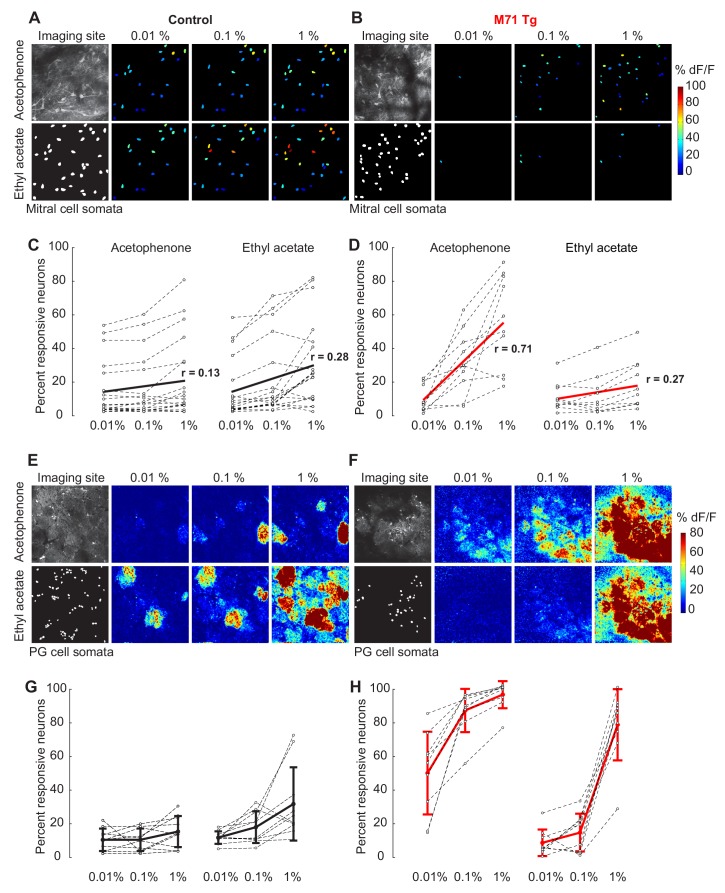
The olfactory bulb excitation/inhibition balance in M71 transgenic mice breaks down at high acetophenone concentrations.(A–D) Two-photon in vivo imaging of mitral cell odor responses in anesthetized mice. (A, B) Representative maps of odor-evoked mitral cell activity elicited by acetophenone and ethyl acetate at increasing odorant concentrations in a control (A) and M71 transgenic (B) mouse. Weak to strong responses are color-coded in blue to red. (C, D) Mean fraction of mitral cells that respond to acetophenone and ethyl acetate at increasing odorant concentrations in control (C, black) and M71 transgenic (D, red) mice. Grey circles represent the fraction of responsive cells of a single imaging site. Controls: 19 imaging sites in 8 mice, n (median number of cells per site) = 57; M71 transgenics: 10 imaging sites in 4 mice, n = 28. red line: linear fit onto concentration. r: coefficient of correlation. (E–H) Two-photon in vivo imaging of periglomerular cell activity in anesthetized mice. (E, F) Representative maps of odor-evoked periglomerular (PG) cell activity elicited by acetophenone and ethyl acetate at increasing odorant concentrations in a control (E) and M71 transgenic (F) mouse. Note that the heatmaps predominantly reflect dendritic responses of PG cells in glomeruli. (G, H) Mean fraction of PG cells that respond to acetophenone and ethyl acetate at increasing odorant concentration in control (G, black) and M71 transgenic (H, red) mice. Grey circles represent the fraction of responsive cells of a single imaging site. Controls: 10 imaging sites in 5 mice, n (median number of cells per site) = 46; M71 transgenics: 9 imaging sites in 5 mice, n = 51. Error bars = SD.